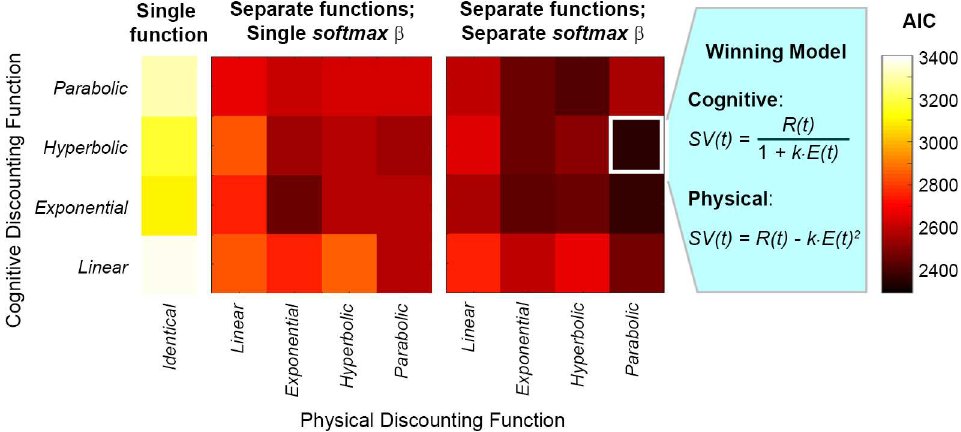
Fig 3. Computational modelling revealedthat reward devaluation by cognitive and physical effort was best described by different functions. The winningmodel indicatedthat cognitivevaluationwas best fitted by a hyperbolicfunction and physicalvaluationby a parabolicfunction. Three classes of model were compared, based on whethercognitiveand physicaleffort were assumed to discountreward with single or separate functions, or single or separate softmax β s. Models were fitted using maximum likelihoodestimationand compared with an Akaike Information Criterion (AIC) (illustratedhere). Additional model comparisons using a Bayesian Information Criterion (BIC) revealedthe identicalpattern of results (S5 Fig). SV ( t ) represents the subjectivevalue of the offer on trial t , R is the reward in credits (2, 4, 6, 8, or 10), E is the effort level (0.2,